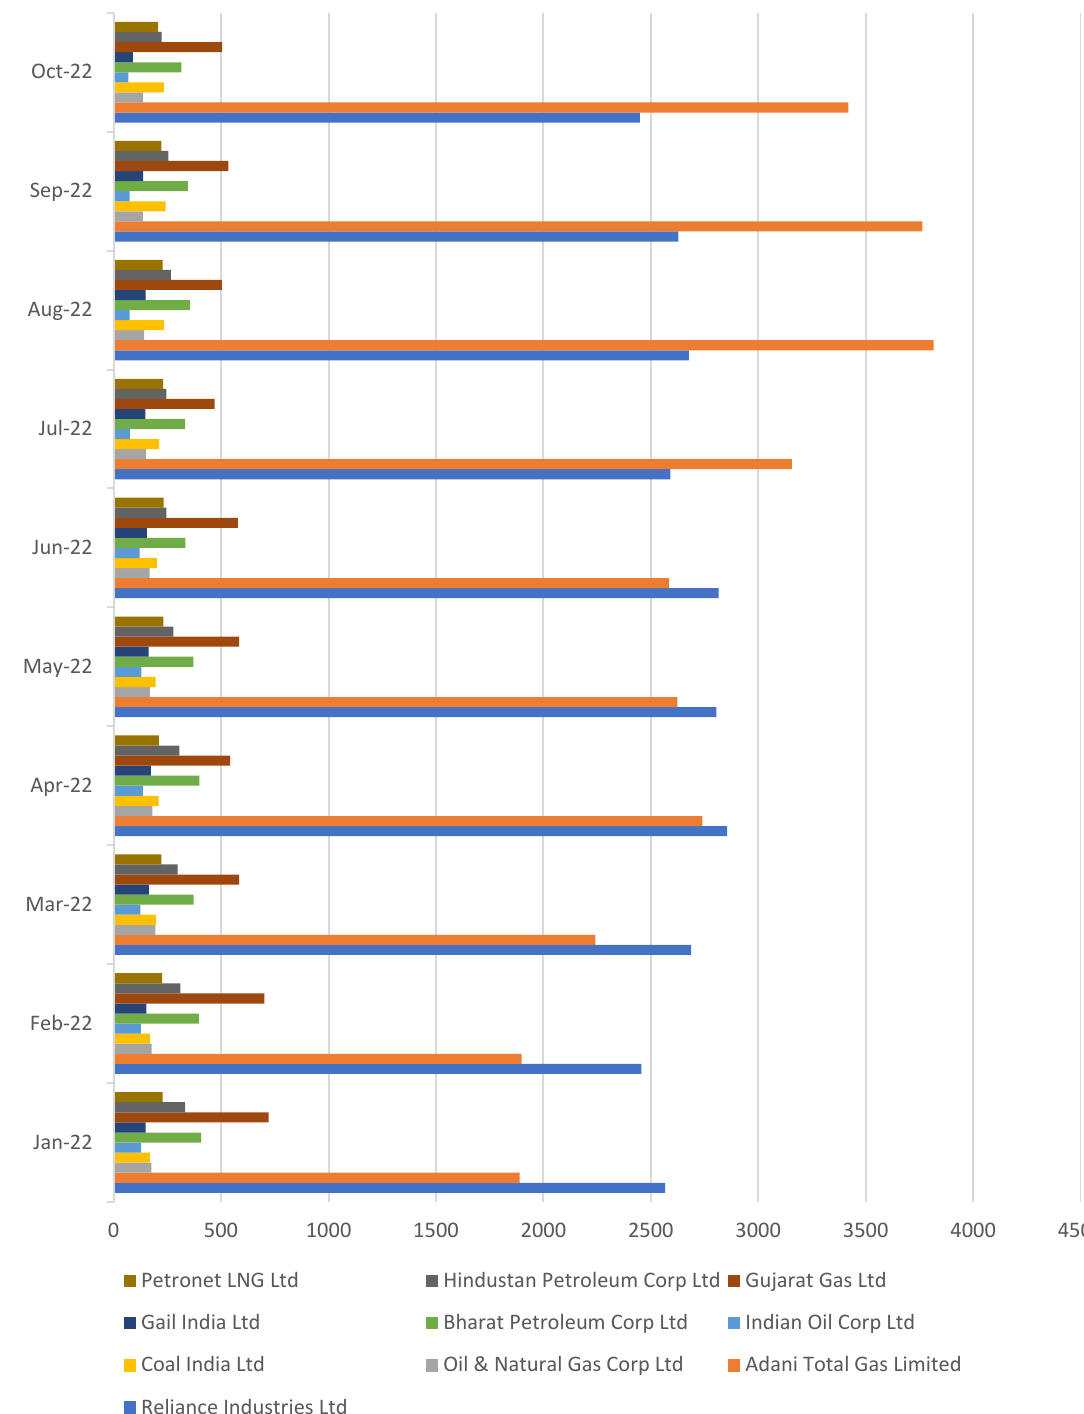
Figure 7. S&P BSE Energy Index Top Ten Companies’ Monthly Performance January 2022– October 2022. Source: https://www.bseindia.com/markets/equity/EQReports/StockPrcHistori. aspx?expandable=7&scripcode=542066&flag=sp&Submit=G (accessed on 11 October 2022)